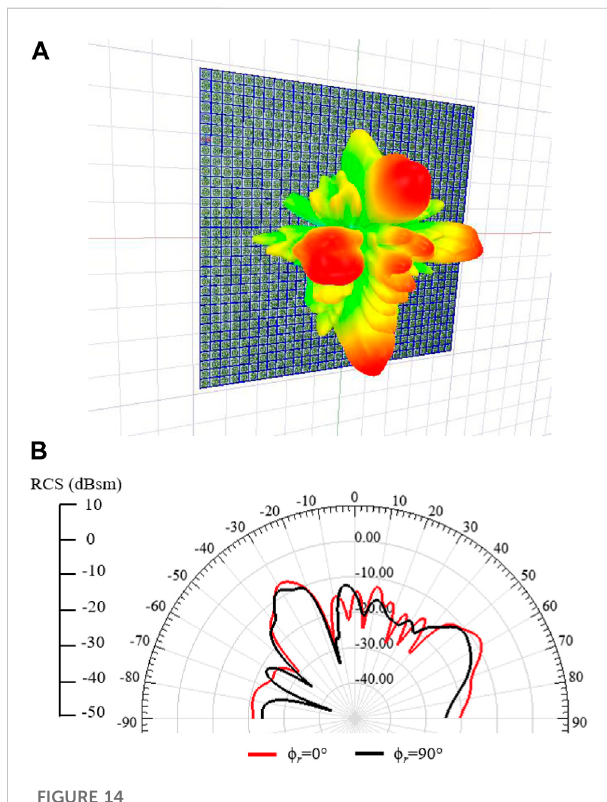
FIGURE 14 SimulatedRISmulti-beamresponse. (A) 3-DRCSpattern. (B) 2-D RCS pattern.